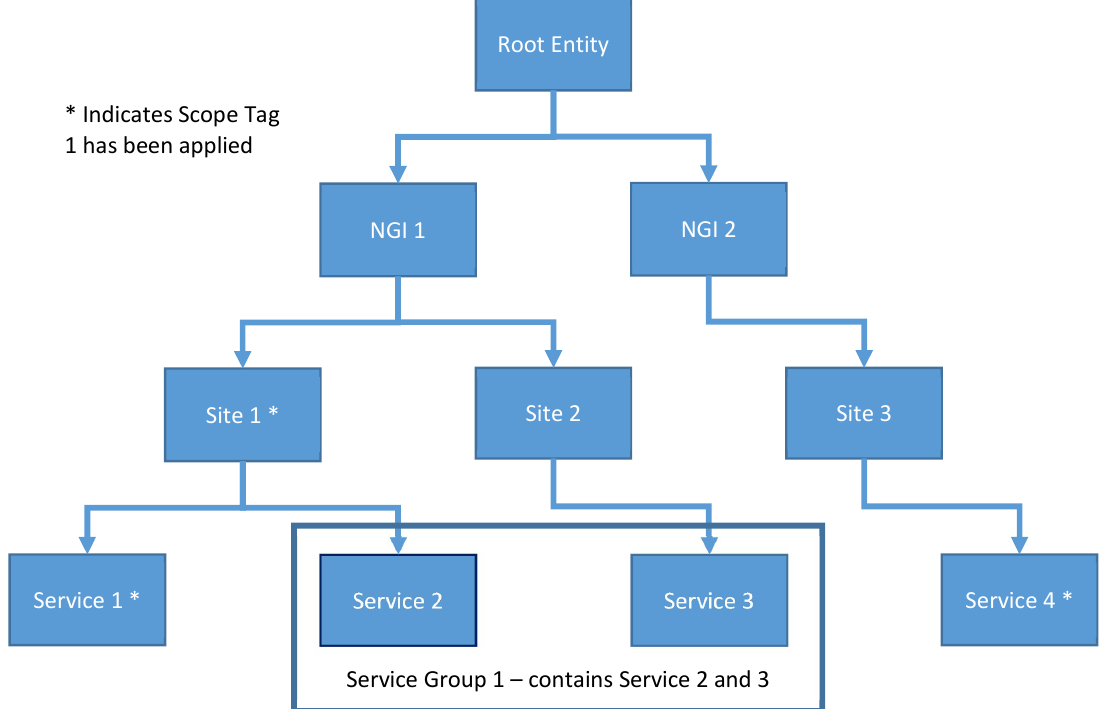
Fig. 1. The hierarchical tree of entities within